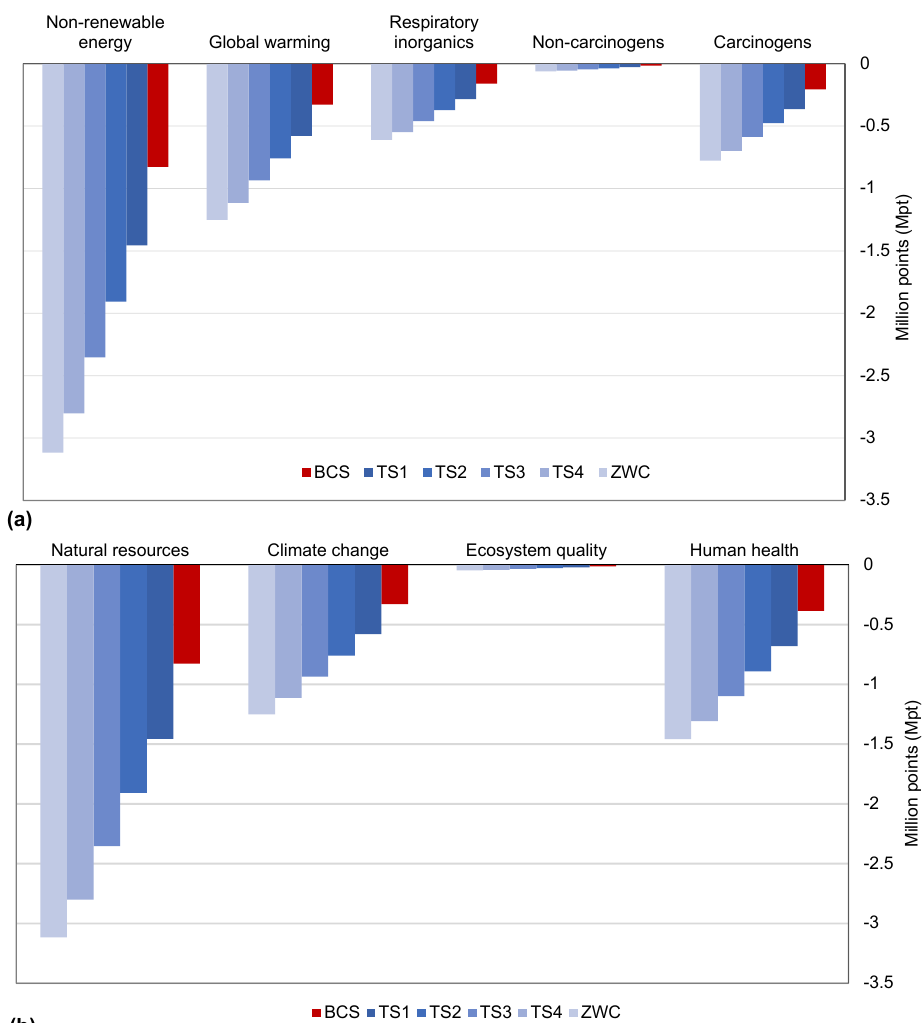
Figure 6. Variation factor for all scenarios with respect to the BCS with variation factor equal to 1. The terms BCS, TS, and RR represent BCS, treatment scenario, and recycling rate, respectively.